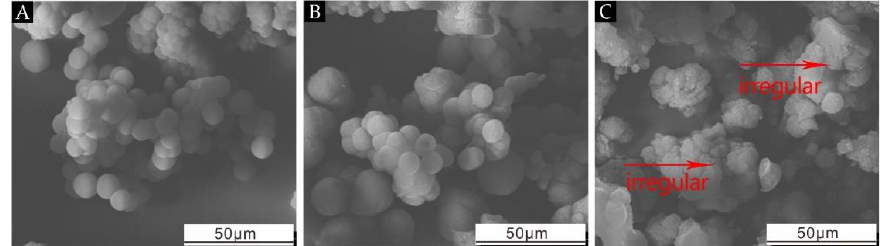
Figure 1. SEM (scanning electron microscope) images of microcapsules with three core-wall ratios ( A ) microcapsules with core-wall ratio of 0.40; ( B ) microcapsules with core-wall ratio of 0.67; ( C ) microcapsules with core-wall ratio of 0.83.